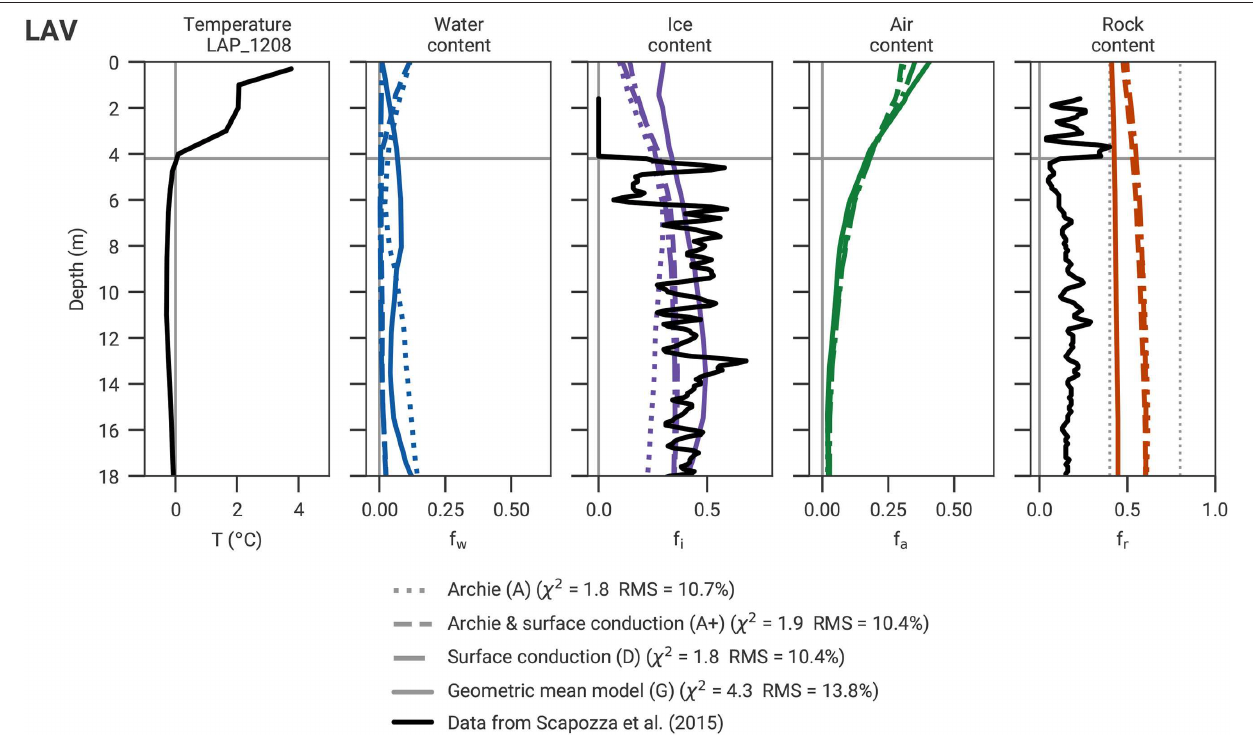
FIGURE 11 | Borehole temperature measured in LAP_1208 and corresponding four-phase constituents estimated by the joint inversion of LAV, including the corresponding data derived from nuclear logging performed by Scapozza et al. (2015) at Lapires. 0 ◦ C temperature lines and thaw depths are marked by gray lines. Vertical dotted lines mark the rock constraint limits (from the prescribed porosity